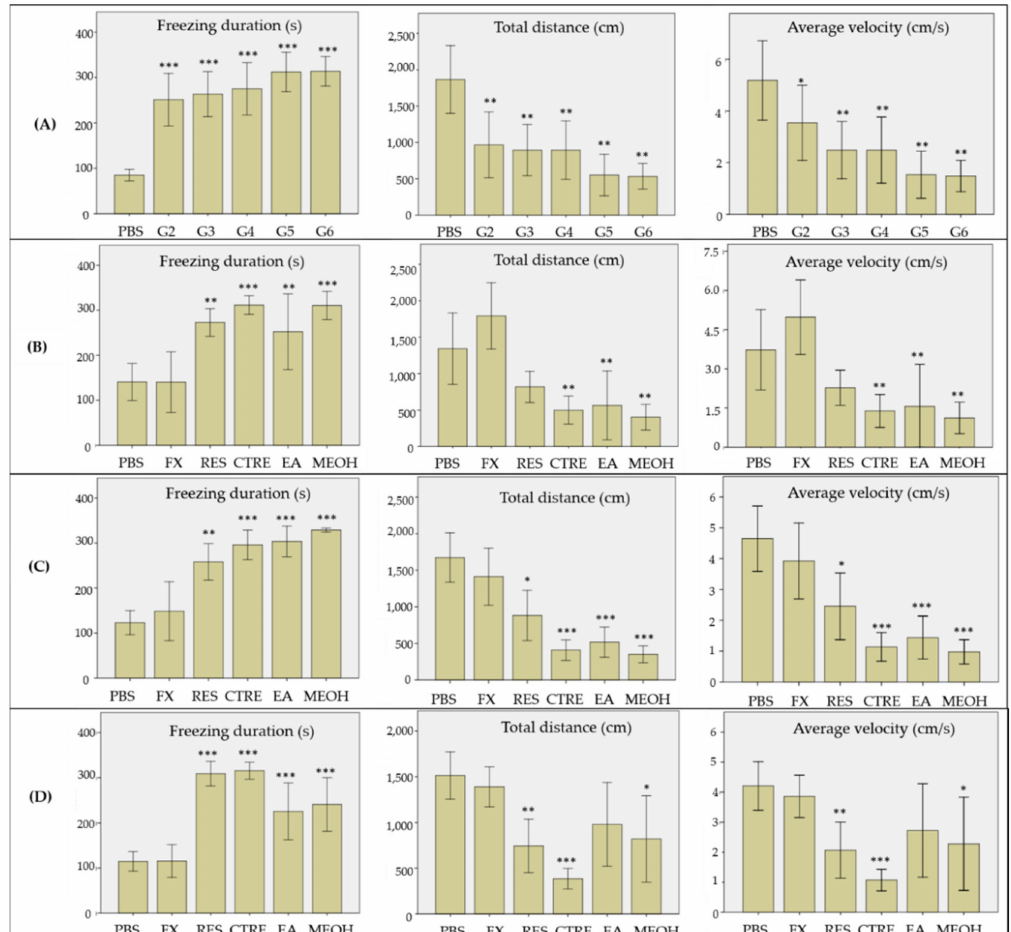
Figure 4. Behavioral effects of the crude methanolic extract, EA, and 50% MeOH fractions of Clitorea ternatea roots on the reserpine-induced stress zebrafish model. Behavioral measurements were recorded at ( A ) 24 h after IP injection of reserpine, ( B ) 24 h after treatments, ( C ) 48 h after treatments, and ( D ) 72 h after treatments for each group, i.e., fluoxetine (0.6 mg/mL, 30 min), CTRE, EA, and 50% MeOH fractions groups (35 mg/mL, 6 h). All values are reported as mean percentage ± SE ( n = 10 per group). Duncan’s post-hoc test was used for significant differences, where * = p < 0.05, ** = p < 0.01, and *** = p < 0.001. PBS: phosphate buffer saline; FX: fluoxetine; RES: reserpine; CTRE: crude C. ternatea extract; EA: ethyl acetate; MEOH: 50%